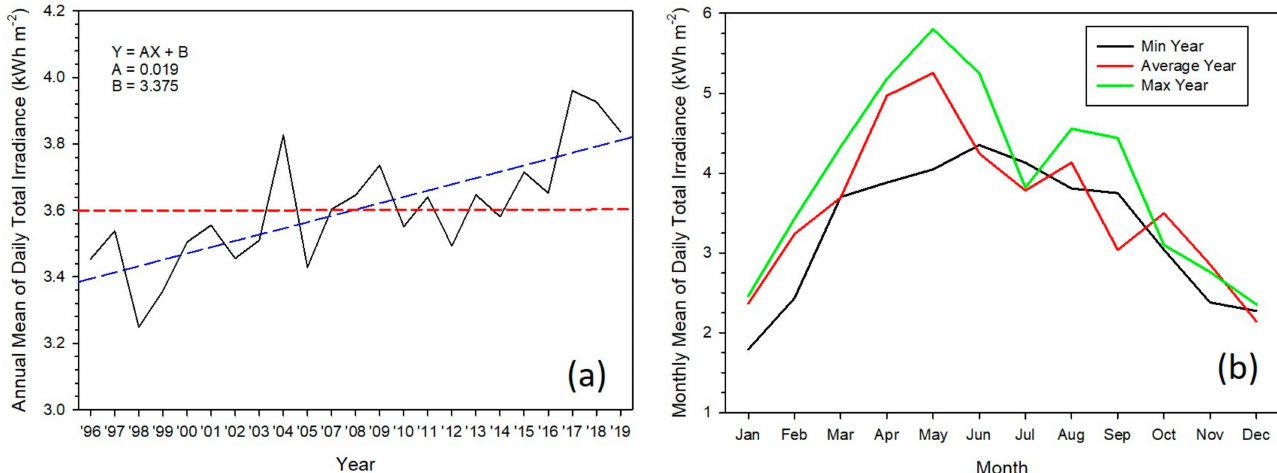
Figure 7. Time series of daily total irradiance that is estimated by the UASIBS–KIER model from 1996 to 2019 in Korea; annual mean ( a ) and monthly mean ( b ). The red and blue line in ( a ) indicate the average value for 22 years and trend line, respectively. The black, green and red line mean the monthly variations at dark, bright and average year,